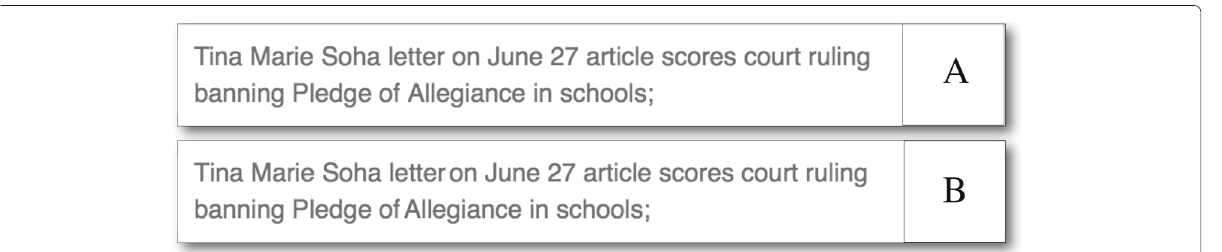
Fig. 8 Graphic rendering of original and watermarked. A lead paragraph from a New York Time article before watermarking ( a ) and after watermarking ( b )